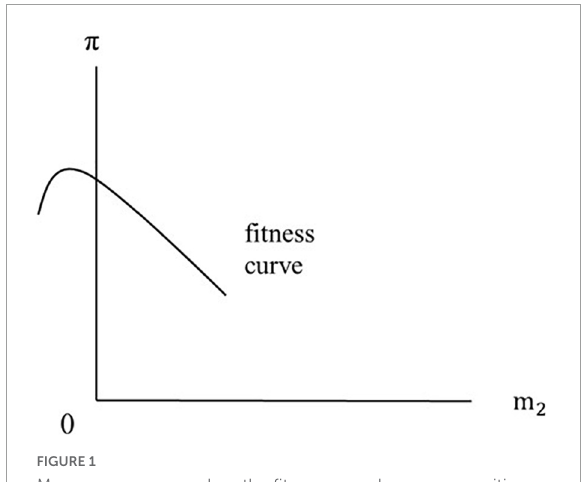
FIGURE1 Menopause occurs when the fitness curve has a non-positive slope around the vertical axis. If the slope around the vertical axis is exactly zero, then d π / d m 2 =